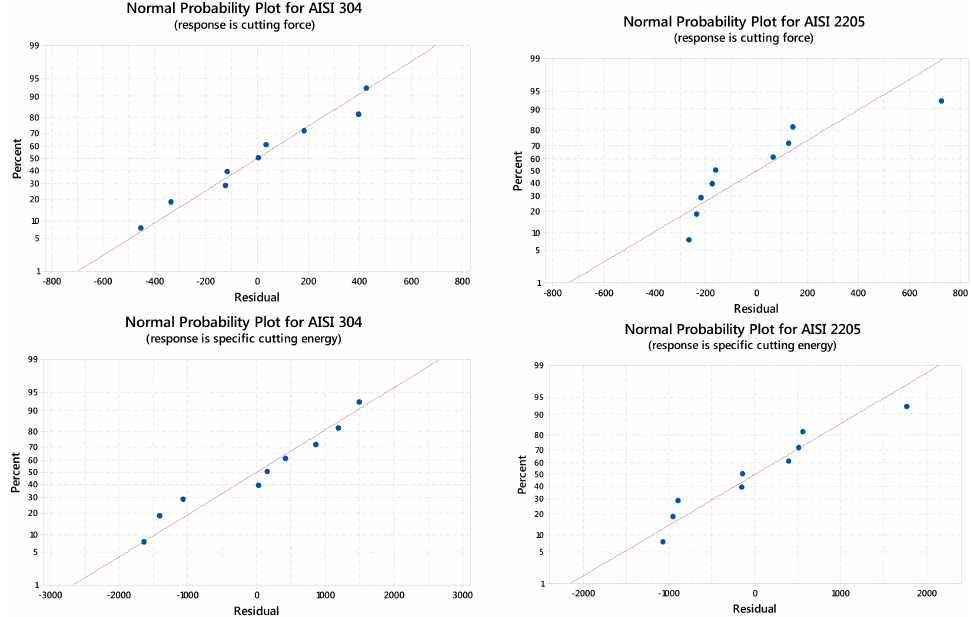
Figure 5. Normal probability plots of the residuals for ( Left ) AISI 304 and ( Right ) AISI 2205 stainless